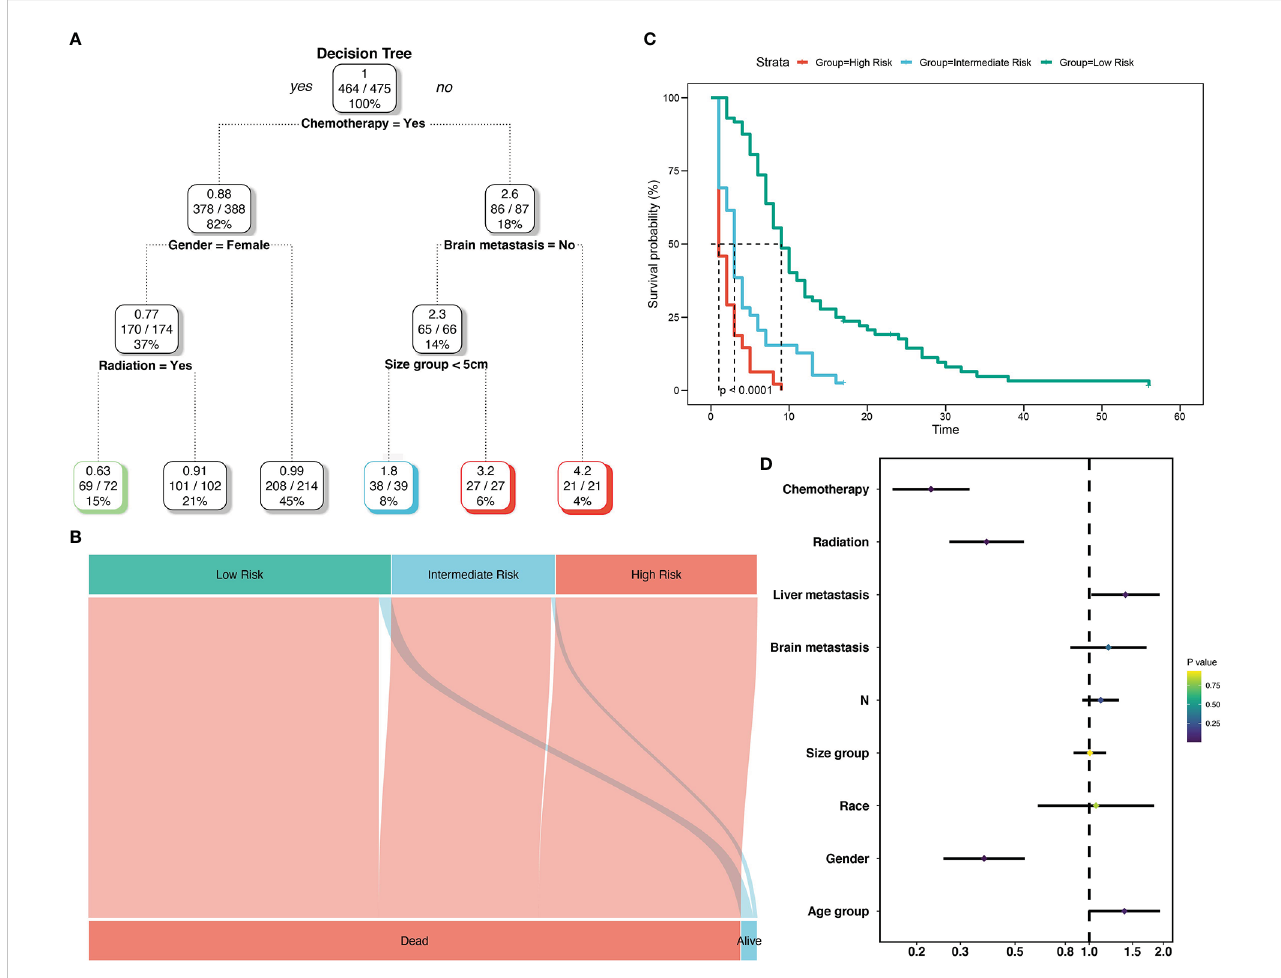
FIGURE 8 Decision tree analysis model for overall survival of SCLC patients with BM. Decision tree (A) ; Decision tree analysis results into different risk groups (B) ; Survival curves for different risk groups (C) ; Forest map (D)